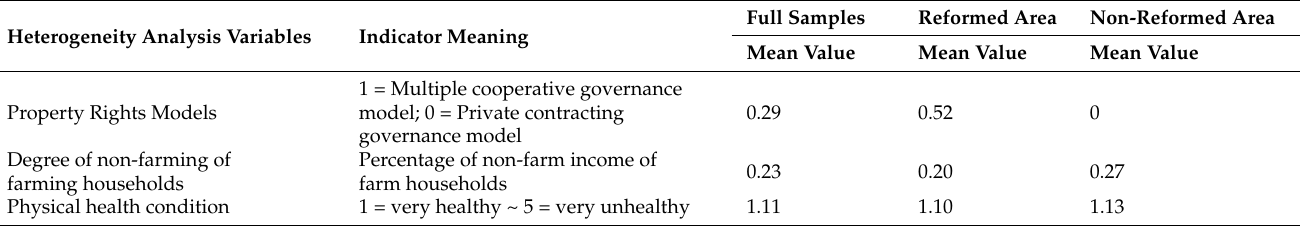
Table 5. Meaning of indicators and descriptive statistics of heterogeneity